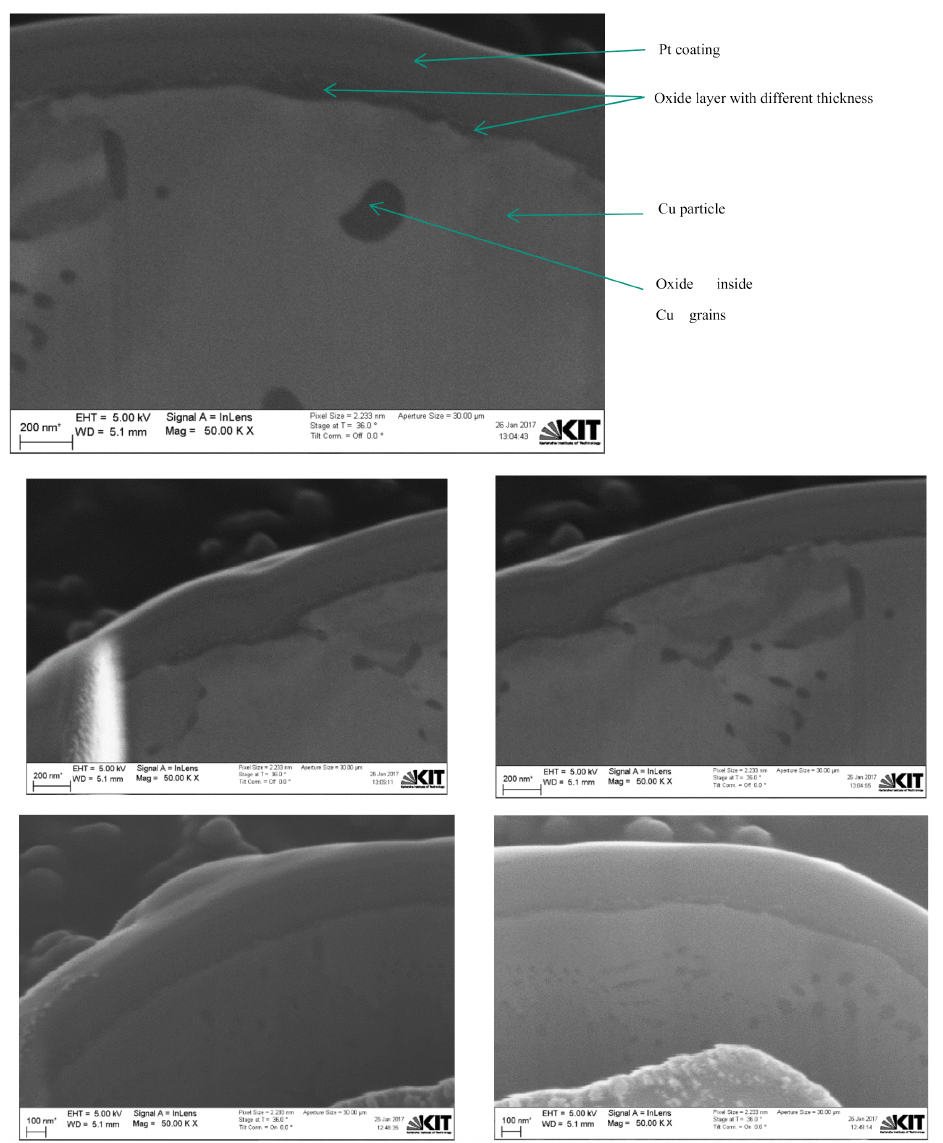
Figure 13. Dual FIB-SEM images of Cu particles with 10 µ m APS with the InLens detector at a 36 ◦ angle tilt at various